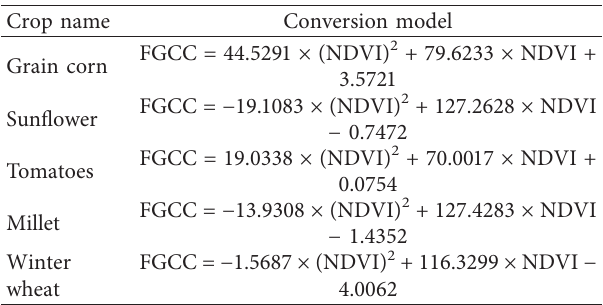
Table 4: The NDVI models into the FGCC conversion for the studied